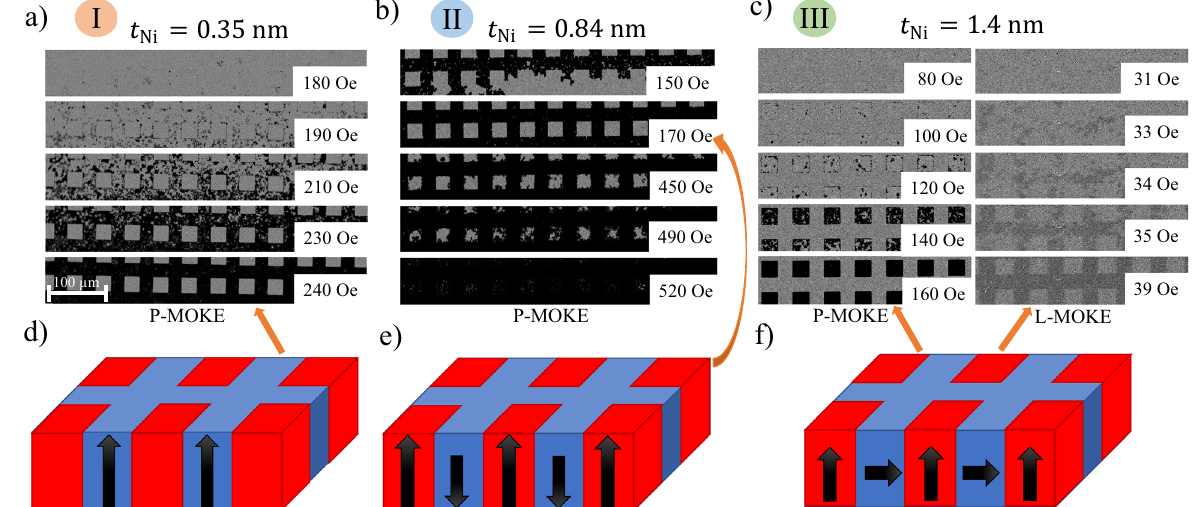
Figure 6. Magnetic patterning by plasma oxidation of buffer/Co 1.4 nm/Ni- t Ni (wedge 0–5 nm) system: ( a – c ) evolution of magnetic domain structure of matrix and squares after plasma oxidation with τ Ox = 110 s, for t Ni = 0.35, 0.84 and 1.4 nm, respectively. ( c ) P-MOKE images of magnetic domains for squares and L-MOKE (in-plane sensitivity) for matrix. Numbers describe different magnetic states of the matrix and the modified areas, according to Fig. 5. Schematic picture of magnetic states for matrix (blue) and squares (red), respectively: ( d ) non-magnetic state and PMA; ( e ) PMA and PMA; ( f ) IMA and PMA. Orange arrows indicate images to which the diagrams are